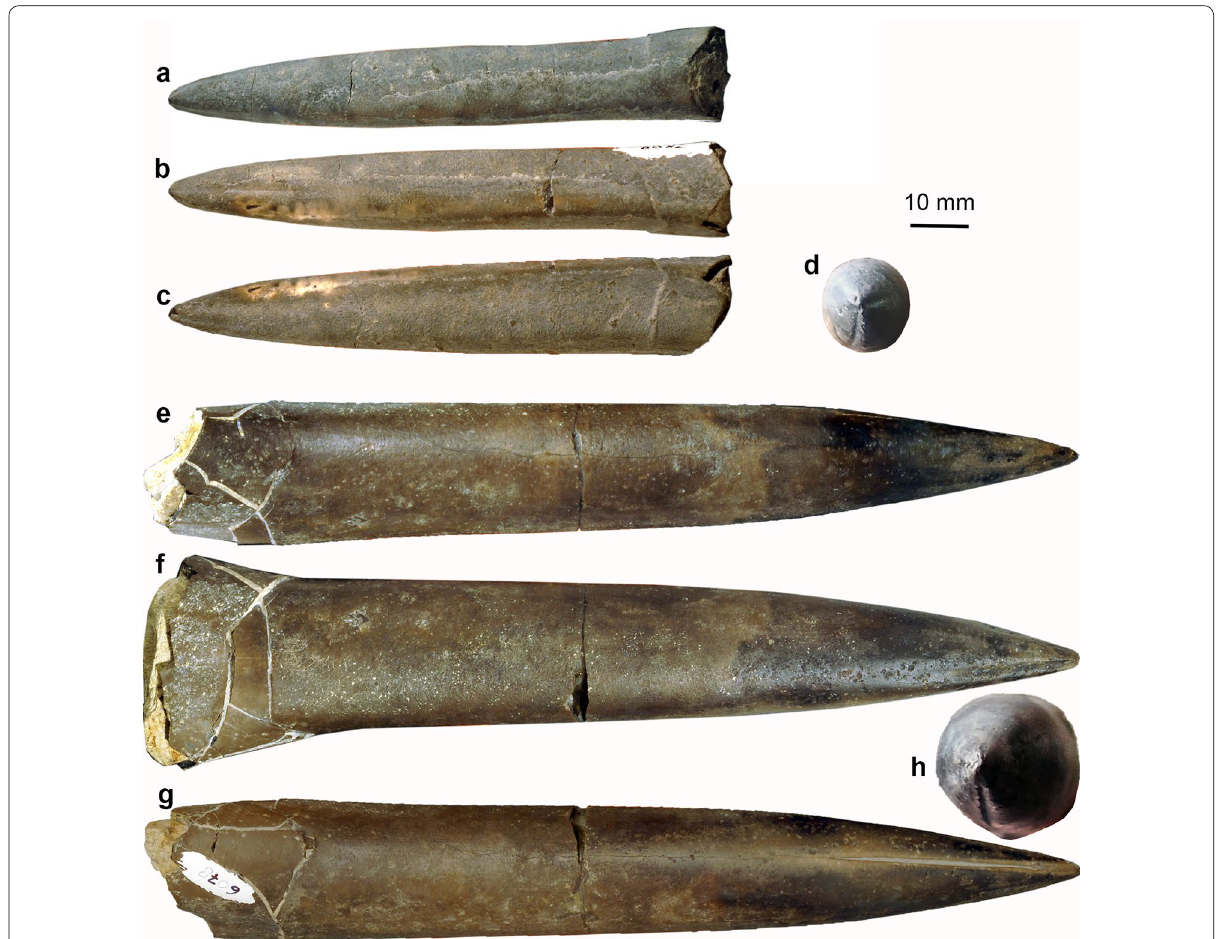
Fig. 3 The most common belemnite rostra (Megateuthidae, Belemnitina) from the Opalinum Clay Formation of northern Switzerland. a– d Acrocoelites quenstedti (Oppel 1856), PIMUZ 6082. a dorsal view. b ventral view. c lateral view. d apical view. e–h Acrocoelites conoideus (Oppel 1856), PIMUZ 6078; large specimen. e dorsal view. f lateral view. g ventral view. h apical